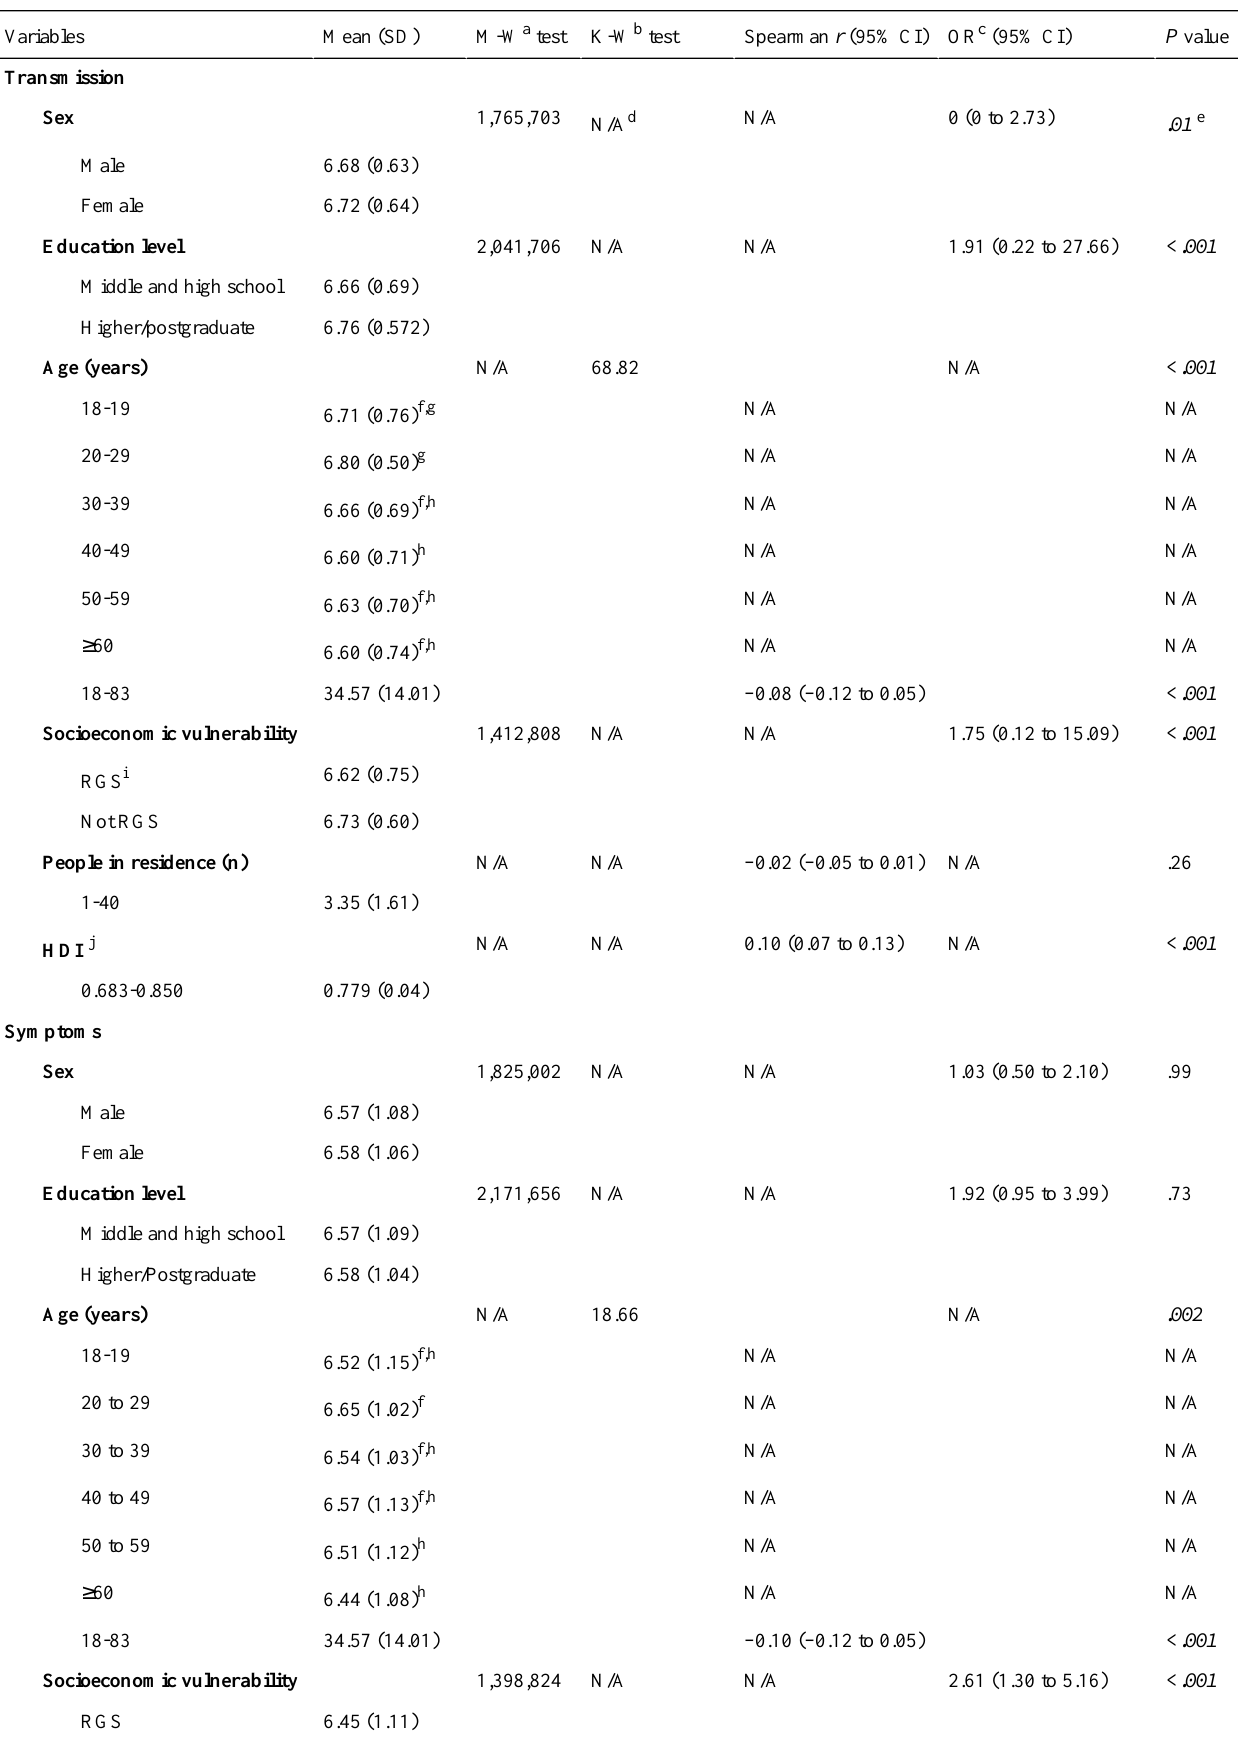
Table 3. Sample statistical analysis based in sociodemographic